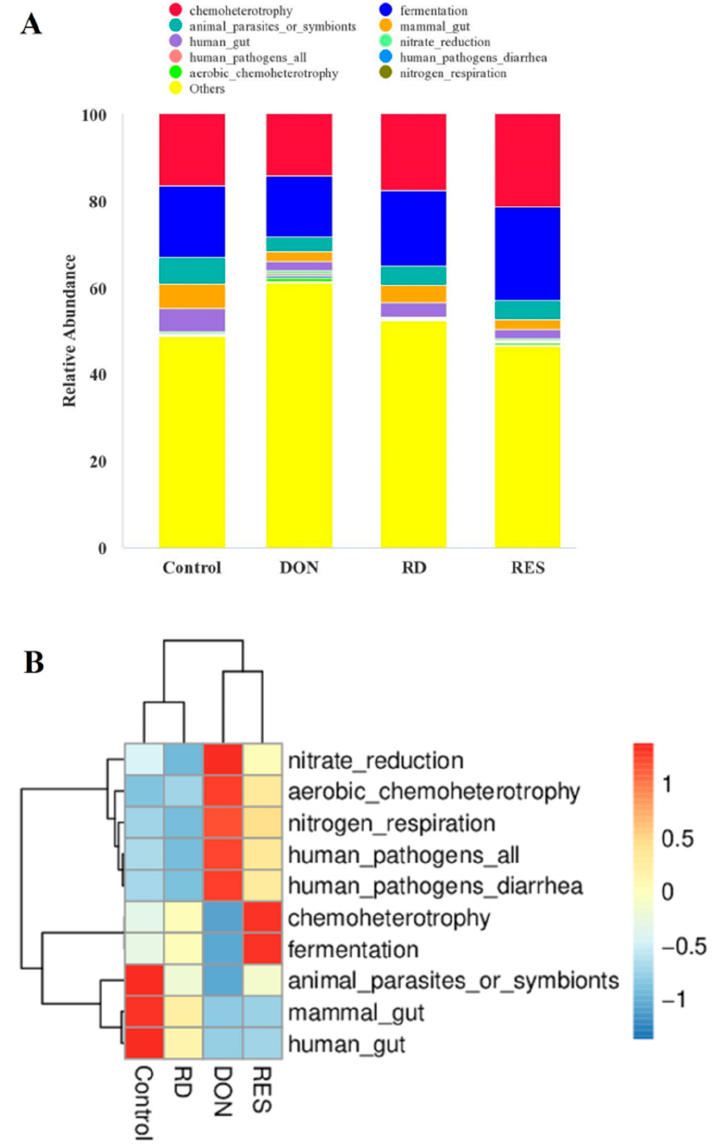
Figure 3. Histogram ( A ) and Heatmap ( B ) showing the predicted function potentials of intestinal microbiota in the piglets with different treatments through FAPROTAX prediction.